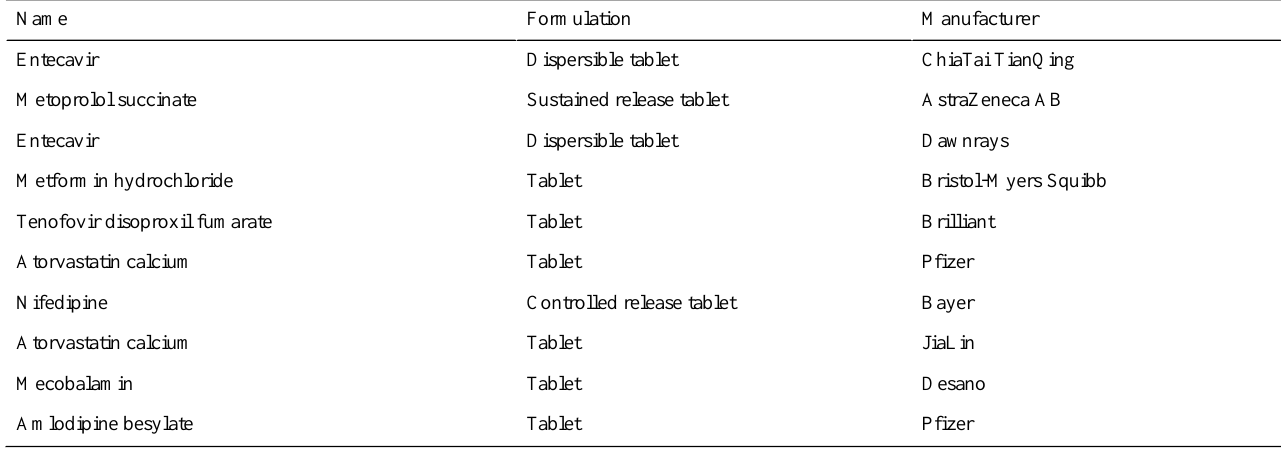
Table 4. Top 10 delivered